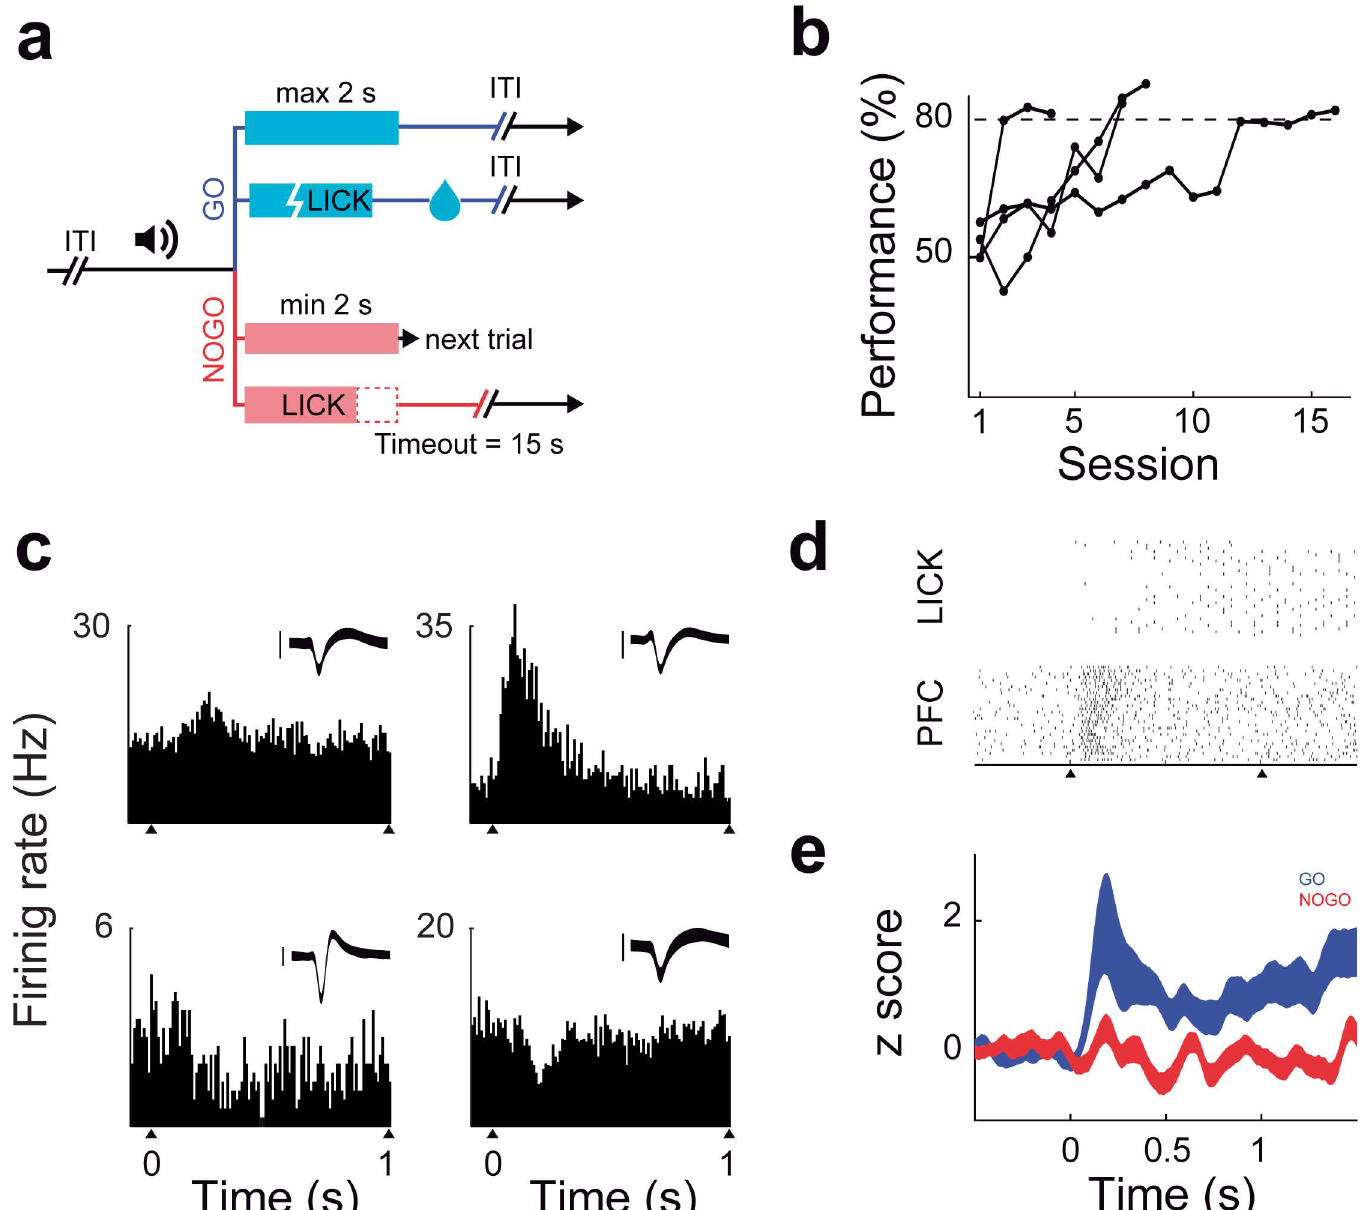
Fig 1. Training protocol, behaviour and neural activity. (a) Animals (n = 6) were trained in a GO/NO-GO paradigm.After a random1–3 s pre-stimulus delay, a 1 s tone (1 KHz or 8 KHz) was presented. Lickingresponses were measuredduringa two seconds opportunitywindowafter stimulus offset. Rats had to lick duringthe opportunitywindowafter the GO tone, and avoid licking after the NOGO tone. Only correct GO responses were rewardedwith a water drop, whilein the case of correct NOGO ones the reward consisted in a reductionin the inter-trialinterval (ITI), givingthe chance to get water sooner in subsequent trials (b) Animalswere trained until they had a session performance higherthan 80% (dashedline) with a NOGO performance higherthan 60%. (c) Peri- stimulus time histograms (PSTH) of PFC neuronsestimated within 10 ms bins. Black trianglesmark the onset and offset of the tone. Examplesof PFC neuronalactivity are depictedto illustrate the different patterns of responses.Insets show neuronspike waveforms (mean ± std), scale bar = 200 μ v) (d) Raster plots showingthe activity of a PFC neuronand the lickingresponses during30 consecutive GO trials. (e) Z-Scored PSTHs for 95 neuronsin PFC duringGO trials (blue) and NOGO trials (red), mean ± s.e.m. values are shown. Comparedwith NOGO trials, the activity of PFC neuronsin GO trials was higherduringand after tone presentation ( P < 0.05,Sign test, measured at 0.5 ms).